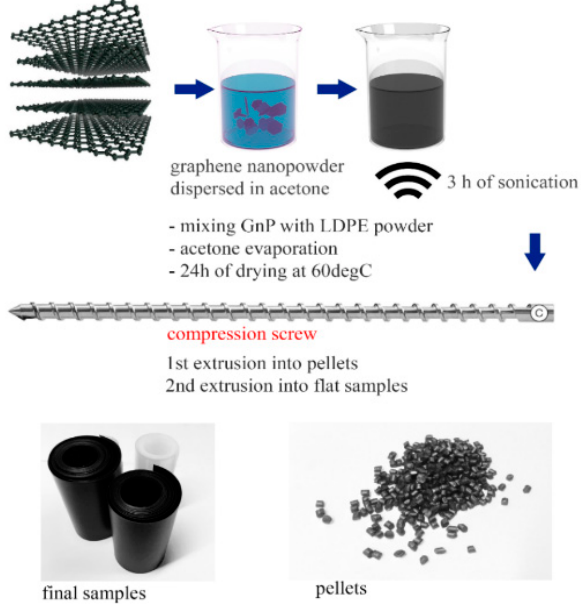
Figure 1. Scheme illustrating samples preparation process.